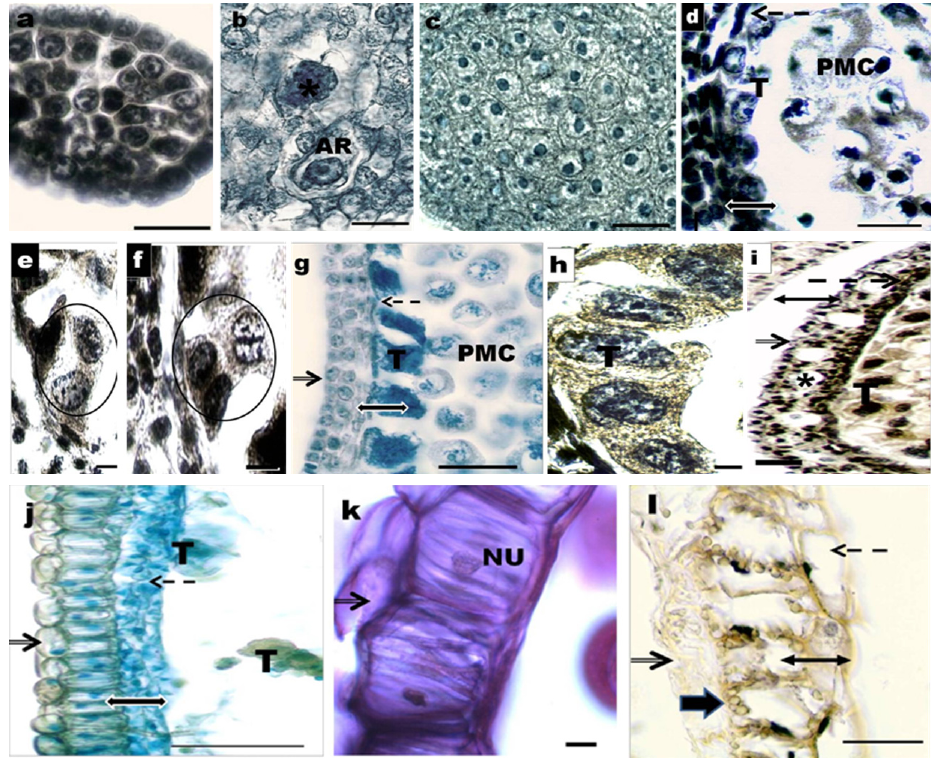
Fig. 6. a. Young, undifferentiated anther tissue, Bar 50 μm ; b. Archesporial cell stained with Coomassie brilliant blue, Bar 50 μm ; c. Sporogenous tissue stained with Coomassie brilliant blue, Bar 50 μm ; d. Young anther wall lay- ers and newly differentiated pollen mother cells, Bar 100 μm ; e, f. The tapetal cells with 2 nuclei (e) and 4 nuclei (f), Bar 10 μm ; g. Anther wall layers and PMCs at meiosis I (leptonema) stained by Coomassie brilliant blue, Bar 100 μm ; h. Big tapetal nuclei formed by the nuclear fusion, Bar 10 μm ; i, j. Anther wall layers at the stage of young pol- len, stained with Coomassie brilliant blue (j), Bar 200 μm ; k. Wall thickenings in endothecium stained by PAS, Bar 10 μm ; l. Anther wall of late pollen development. The tapetum is completely degenerated, whereas the starch grains (thick arrows) are still visible at this stage within the endothecium, Bar 100 μm . T-Tapetum; AR-Archesporium; Idioblast cell (*); NU-Nucleus, Epidermis (→), Endothecium ( ↔ ), Midlle layer